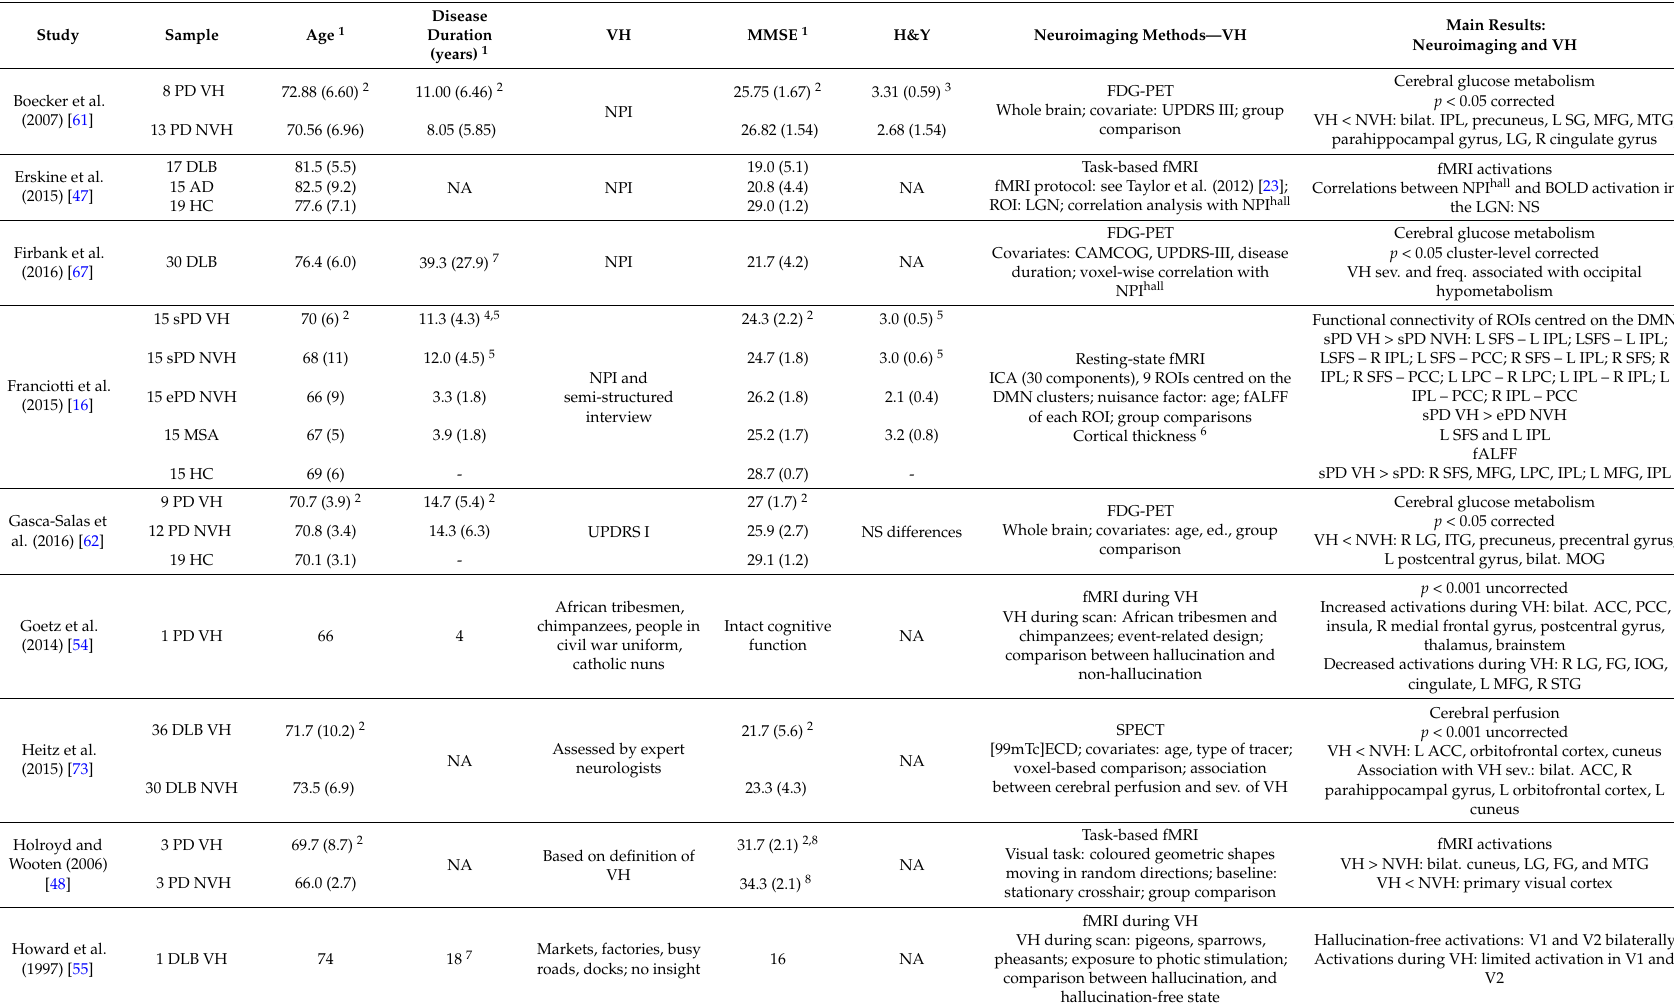
Table A2. Summary of functional neuroimaging studies of hallucinating patients with LBD. Only main results related to VH are reported.